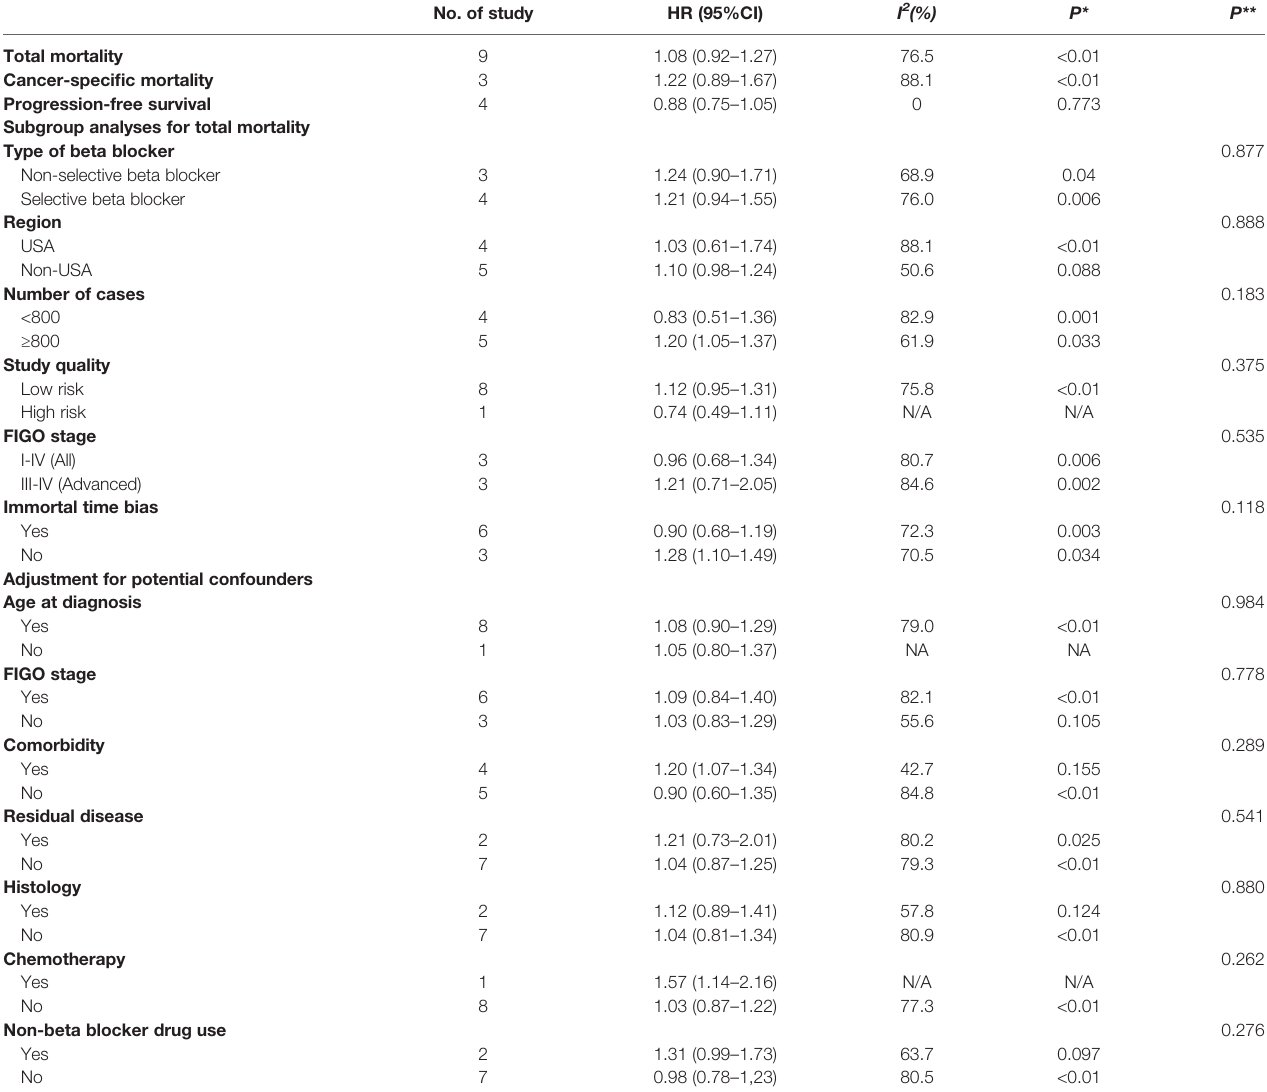
TABLE 4 | Summary risk estimates of the association between post-diagnostic beta blocker use and prognosis of ovarian cancer (user vs. non-user). No. of